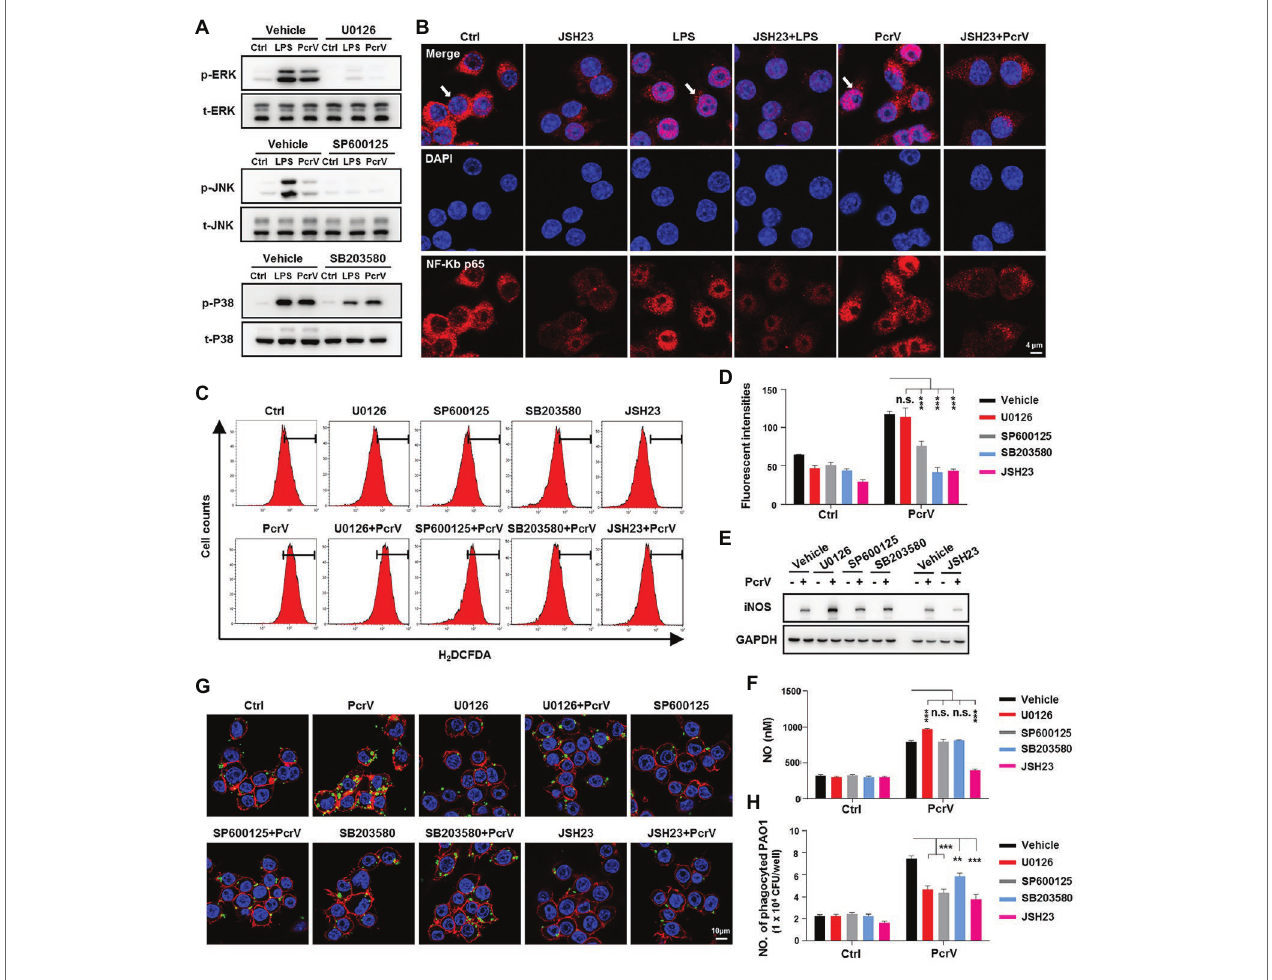
FIGURE 6 | Mitogen-activated protein kinases (MAPKs) and NF- κ B signaling pathways are involved in PcrV-mediated activation of M1 macrophages and increasing of phagocytosis. Raw264.7 cells pretreated with the corresponding inhibitors U0126 (5 μ M), SP600125 (10 μ M), SB203580 (5 μ M), and JSH23 (15 μ M) for extracellular signal-regulated protein kinase (ERK), c-Jun N-terminal kinase (JNK), p38 MAPKs, and NF- κ B, respectively, were primed by LPS + IFN γ (named as LPS group) or PcrV (10 μ g/ml) for 6 h. The total and phosphorylation levels of JNK, ERK, and p38 MAPKs were analyzed by western blot (A) . The cellular translocation of NF- κ B was visualized by immunofluorescence staining (B) . NF- κ B was labeled with AF647-conjugated anti-NF- κ B p65 antibody (red); cellular nuclei were stained with DAPI (blue). ROS (C,D) and iNOS (E) production were analyzed by flow cytometry and western blot, respectively. (F) The concentration of NO in the culture supernatant of Raw264.7 treated with the indicated compound for 24 h was detected by NO detection kit. Raw264.7 pretreated with the corresponding inhibitors was primed by PcrV (10 μ g/ml) for 6 h. The cells were then co-cultured with static PAO1 biofilms (MOI = 10) for 30 min. Phagocytosis was detected by immunofluorescence staining (G) and CFU enumeration (H) . Cytoskeleton was labeled with phalloidin (red); PAO1 was visualized by FITC anti-PAO1 antibody (green); cellular nuclei were stained with DAPI (blue). Unpaired Student’s t test was used for statistical analysis (D,F,H) . ** p < 0.01; *** p < 0.001; n.s. indicates no